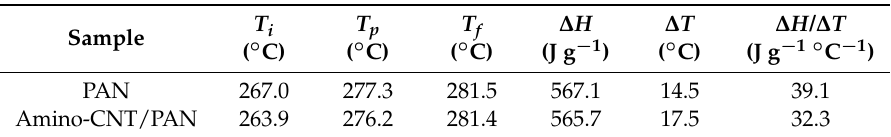
Table 2. Differential scanning calorimetry (DSC) data for PAN homopolymer and amino-CNT/PAN microspheres in a nitrogen atmosphere.